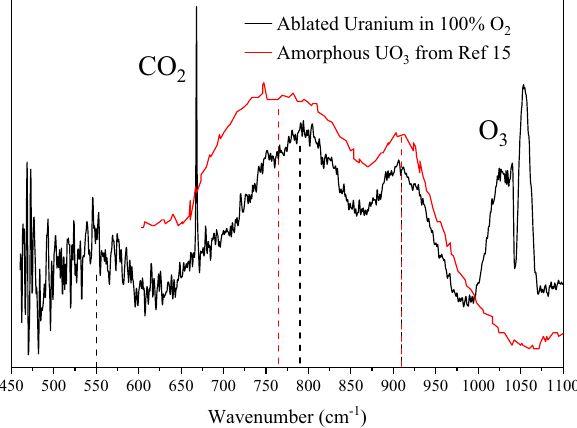
Figure 2. In-situ FTIR spectra of collected particulates after ablation of uranium in 100% O 2 (black). Shown are three features attributed to am-UO x (where 3 ≤ x ≤ 4) as well as ozone and carbon dioxide (produced during ablation). Also plotted is a spectrum of amorphous UO 3 digitized from Hoekstra and Siegel (red) 15 . The experimental spectra, consisting of 30 averaged scans at 1 cm −1 resolution, were collected ~ 1 min after ablation.